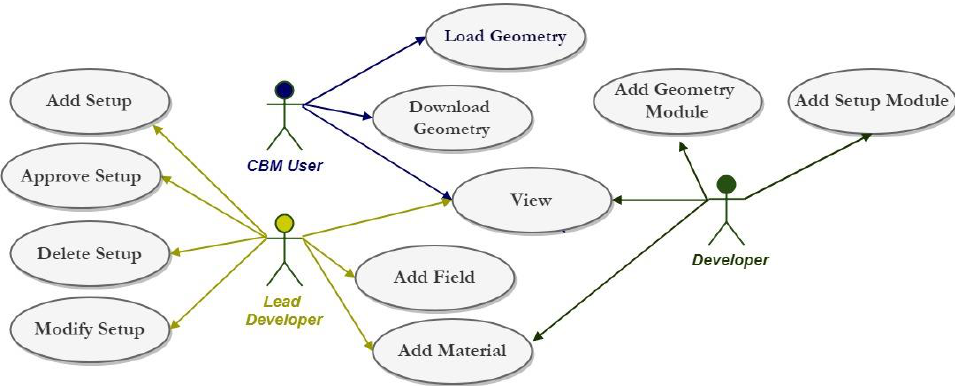
Fig. 2. Use cases of the Geometry